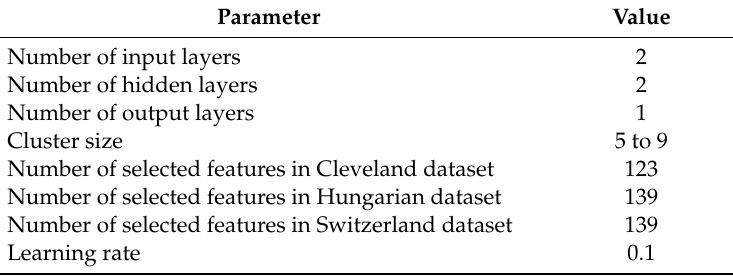
Table 1. Simulation